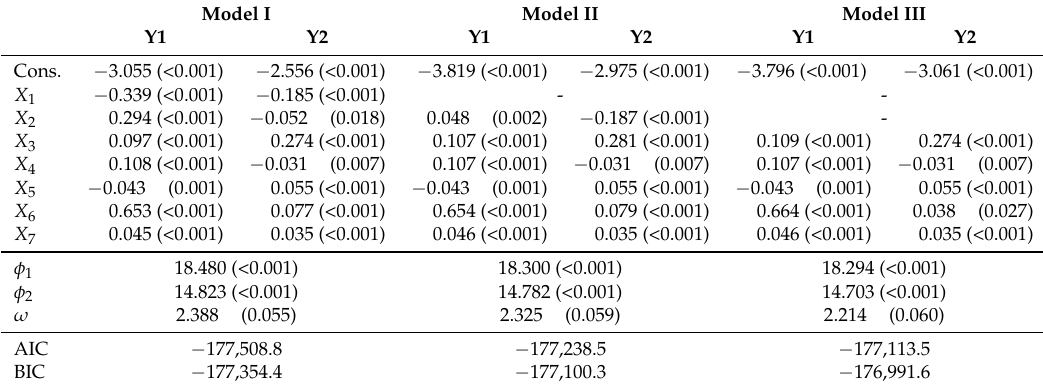
Table 3. Parameter estimates ( p -values) for the Sarmanov-Beta models and goodness of fit statistics.